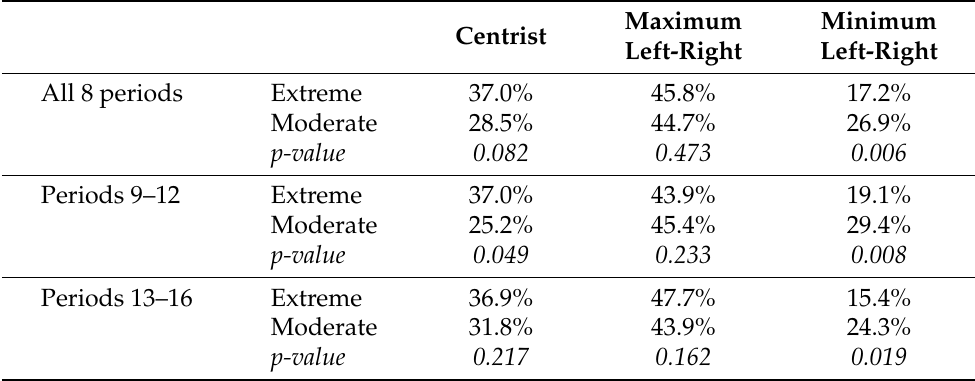
Table 1. Candidates’ vote